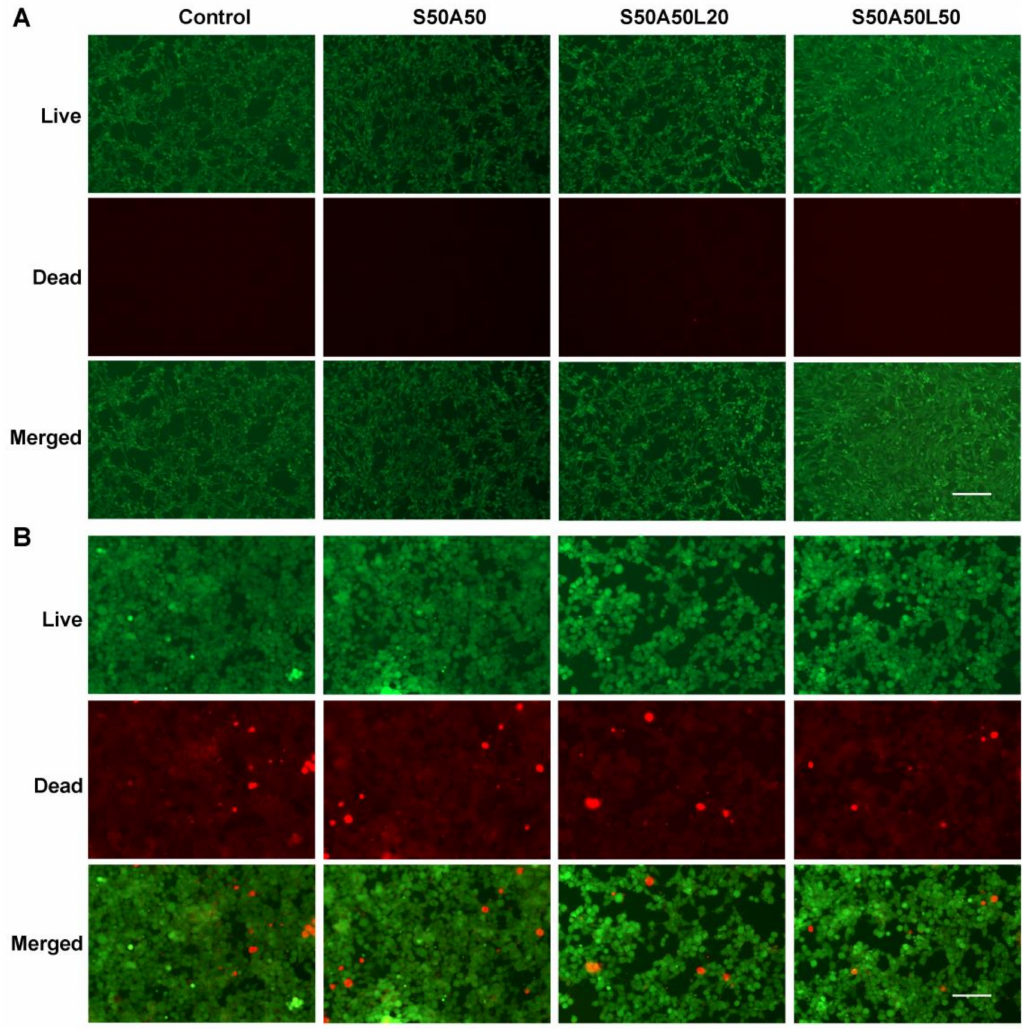
Figure 7. The LIVE/DEAD staining assay. NIH3T3 (( A ), scale bar, 200 µ m) and HEK293 (( B ), scale bar, 100 µ m)